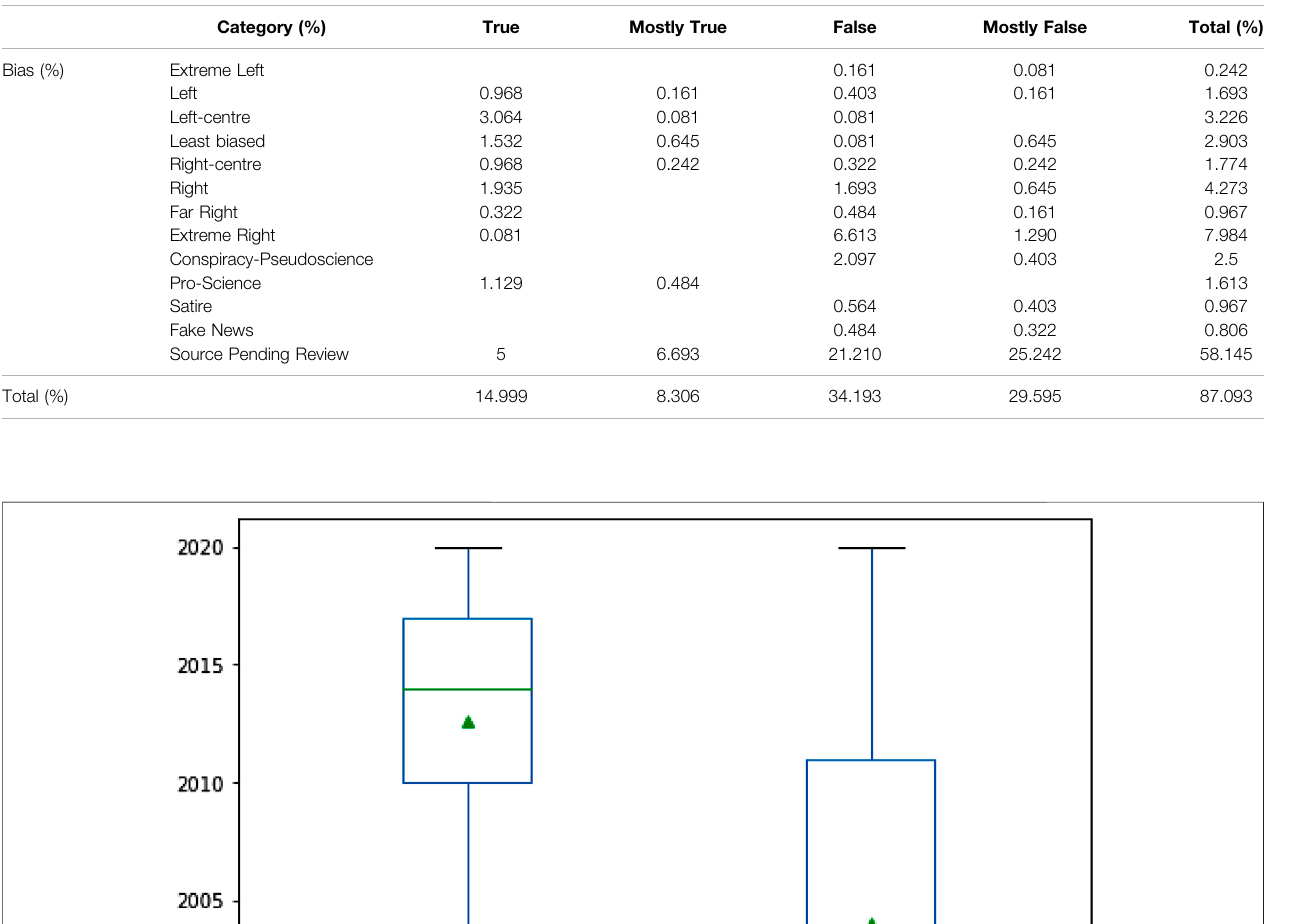
Frontiers in Physics |